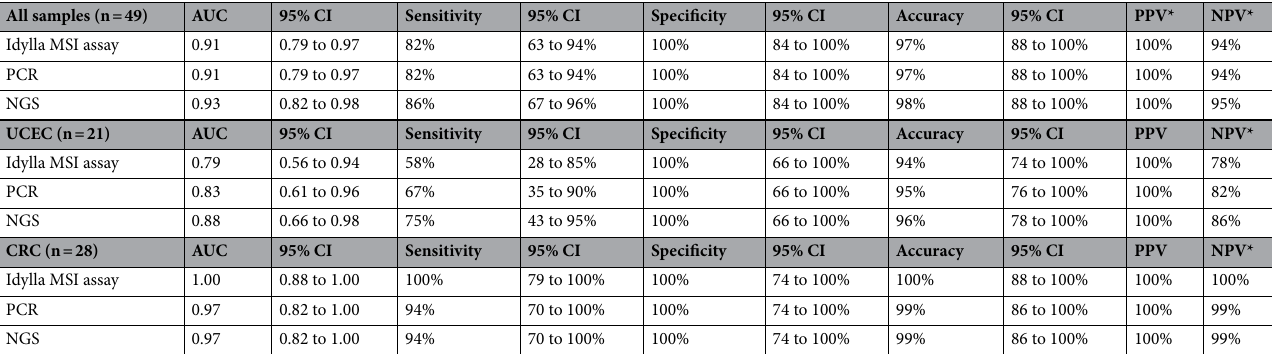
Table 1. Diagnostic performance of three molecular MSI tests versus IHC as reference test in colorectal (CRC) and uterine corpus endometrial (UCEC) cancer. Overview of diagnostic performance expressed as area under the receiver operating characteristics (ROC) curve (AUC), sensitivity, specificity and accuracy with 95% confidence intervals of the three molecular assays in all samples (n = 49) or grouped according to colorectal (CRC, n = 28) or uterine corpus endometrial cancer (UCEC, n = 21) tumor type. The negative and positive predictive values (NPV, PPV) are calculated assuming a prevalence of microsatellite unstable tumors in real- world clinical practice of 15% in CRC, 40% in UCEC and 26% in all samples. AUC area under the receiver operating characteristics (ROC) curve, CI confidence interval, NPV and PPV negative and positive